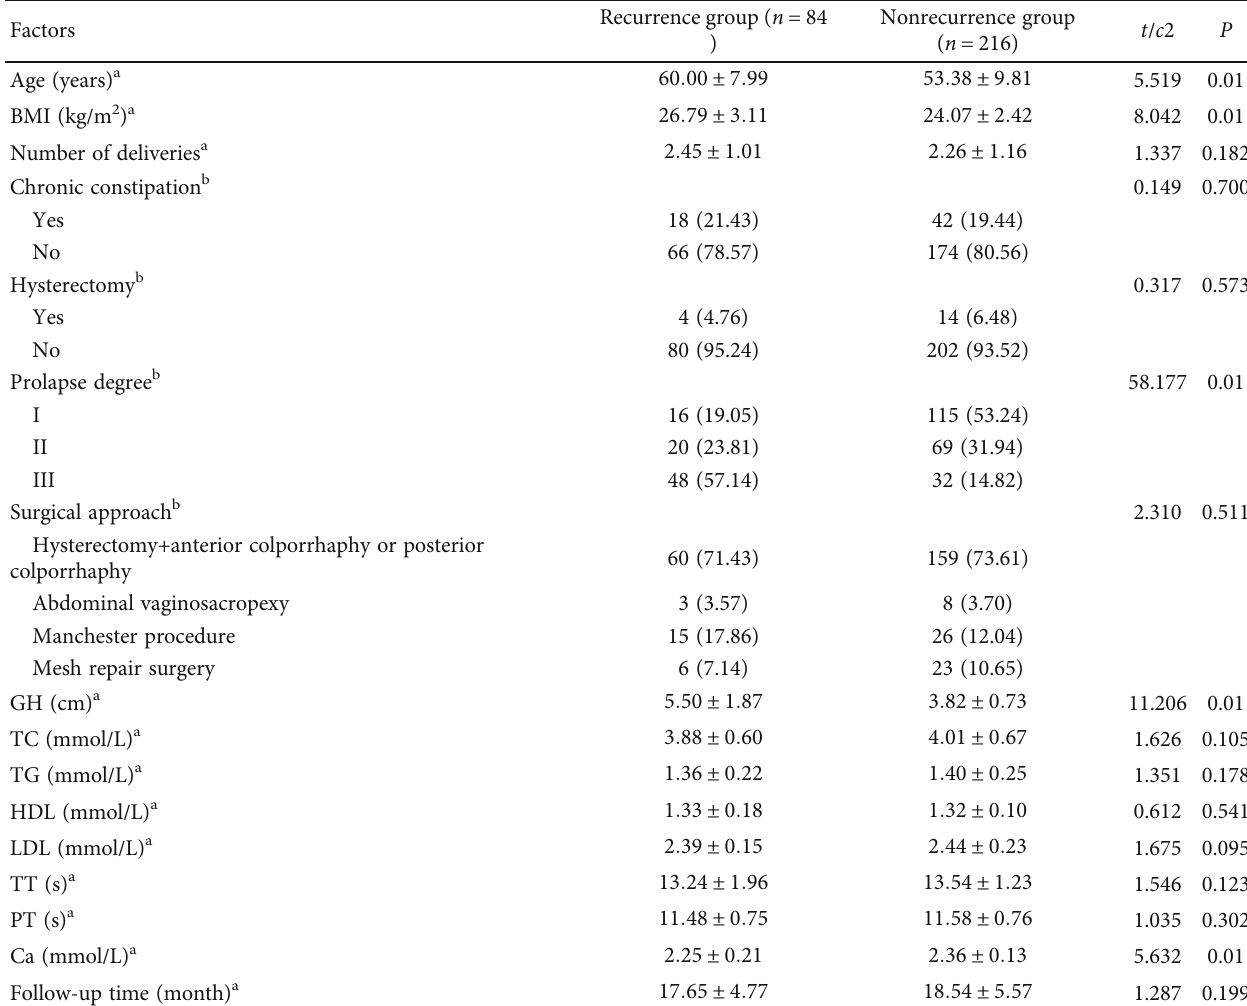
Table 1: Single factor analysis of the in fl uence of POP postoperative